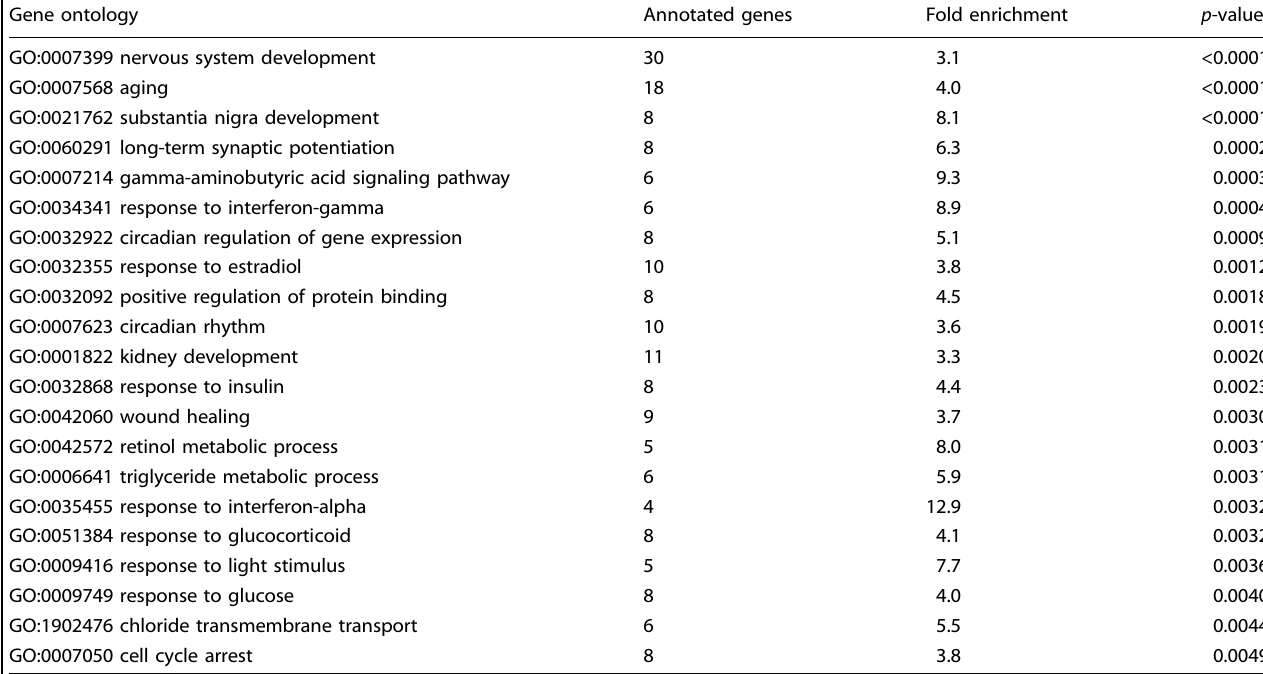
Table 1. Gene ontology terms enriched in the rosmarinic acid